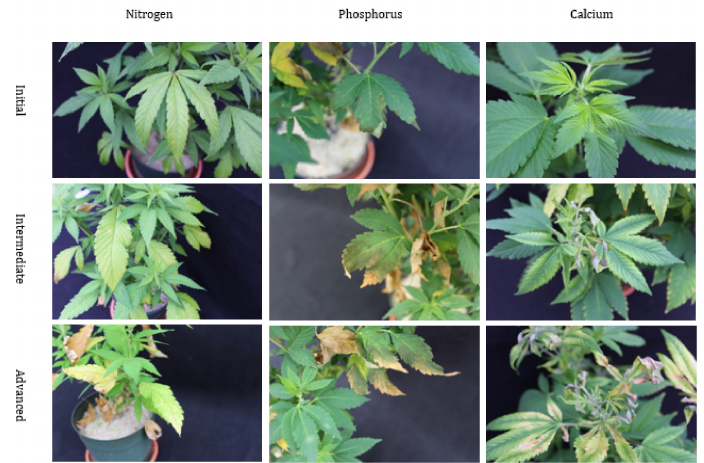
Figure 2. Nutritional disorders of nitrogen (N), phosphorus (P), and calcium (Ca) deficiency in Cannabis sativa ‘T1’ plants. These pictures display the symptomological progression of nutritional disorders from initial, intermediate, through